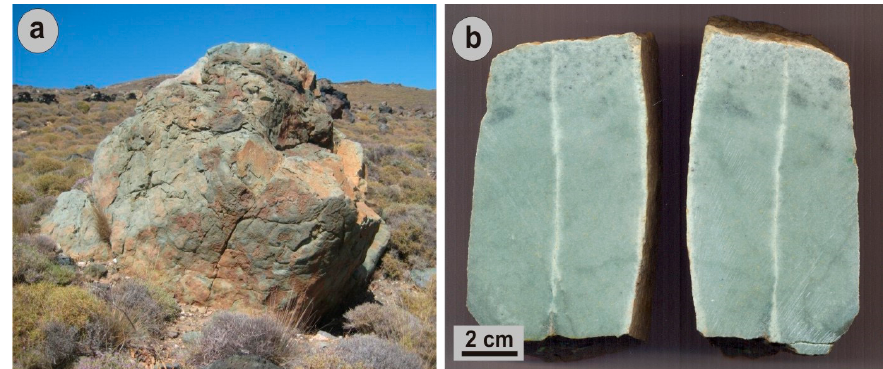
Figure 5. Field photographs ( a ) and hand specimens ( b ) of jadeitite from Kampos, Syros Island. 5.4. Al 2 SiO 5 Polymorphs Kyanite in blue, green, yellowish to orange colored crystals up to 20 cm long, is found in quartz ± feldspar boudins intercalated within metapelites at Trikorfo, Thassos Island (Figure 6a–d) [17,19,47]. Orange kyanite also occurs in association with spessartine, and muscovite. Distinct dark blue color zoning is a common feature in the centre of some light blue kyanite; this color zoning can also be observed in some yellow kyanite. Microprobe analyses for orange kyanite indicate MnO up to 0.1 wt. % contributing to the coloration of the crystals [19] and up to 1.5 wt. % FeO. In a similar occurrence on Naxos Island in the Cyclades, kyanite forms up to 10 cm blue-colored crystals in quartz lenses and veins.